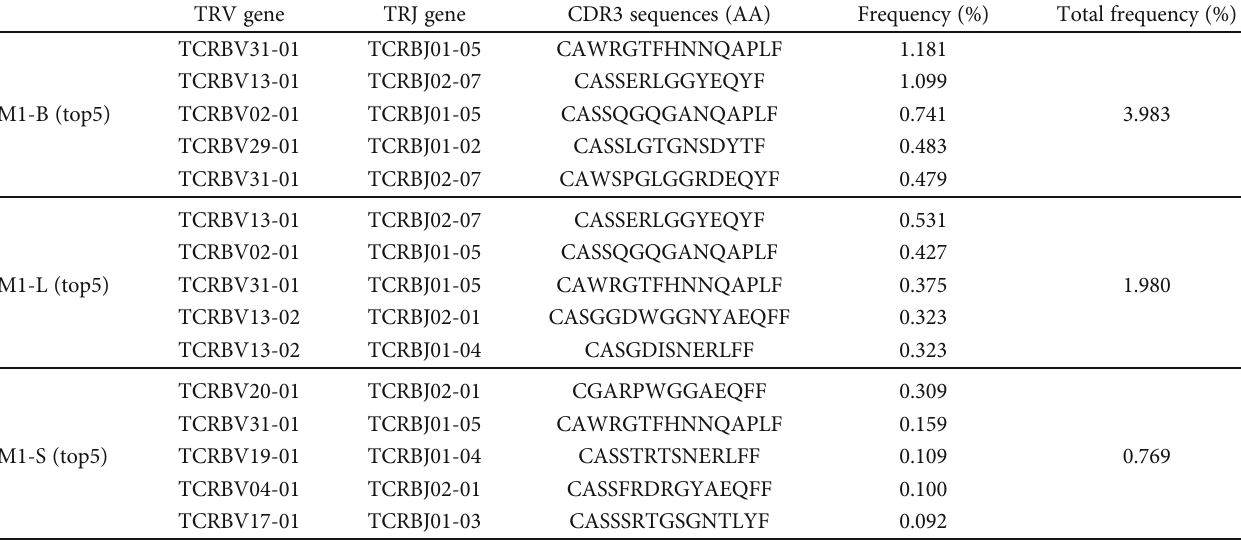
Table 1: Analysis of composition and characteristics of frequency for the top fi ve sequences and the usage of TRBV and TRBJ gene, CDR3 AA of CD4 + CD25 + T cells TCR β CDR3 repertoires in breast tumor tissues, lung metastatic tissues, and spleens from 4T1 tumor-bearing BALB/c mouse 1.